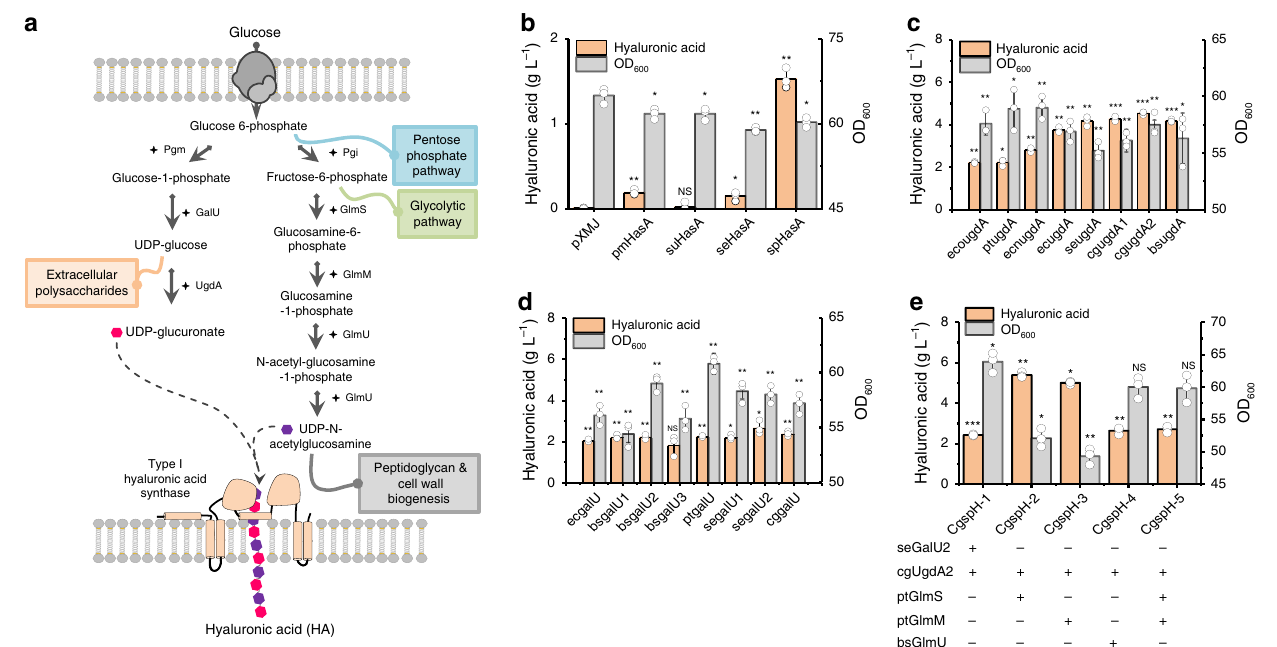
Fig. 1 Engineering C. glutamicum for HA biosynthesis from glucose. a HA chains are elongated by HA synthase (HasA) from two building blocks: UDP- GlcA (uridine diphosphate glucuronate) and UDP-GlcNAc (uridine diphosphate N-acetylglucosamine). Pgm, phosphoglucomutase; GalU, glucose-1- phosphate uridylyltransferase; UgdA, UDP ‐ glucose 6 ‐ dehydrogenase; Pgi, glucose-6-phosphate isomerase; GlmS, L -glutamine- D -fructose-6-phosphate aminotransferase; GlmM, phosphoglucosamine mutase; GlmU, UDP-N-acetylglucosamine pyrophosphorylase/Glucosamine-1-phosphate N- acetyltransferase. b HA synthesis by P. multocida (pmHasA), S. pyogenes (spHasA), S. uberis (suHasA), and S. equi subsp. zooepidemicus HasA (seHasA), respectively in C. glutamicum . c , d Comparison of the activities of UgdA and GalU from different species on enhancing HA production. e Co-overexpression of C. glutamicum cgUgdA2 with S. equi subsp. zooepidemicus seGalU2, P. putida ptGlmS, P. putida ptGlmM or B. subtilis bsGlmU to enhance HA production. All the data are expressed as the mean ± S.D. from three ( n = 3) biologically independent replicates. Statistical evaluation ( p -value) compared to strain pXMJ ( a ), spHasA ( b , c ), or cgugdA2 ( e ) was performed by two-sided t -test. * p < 0.05, ** p < 0.01, *** p < 0.001; NS not signi fi cant ( p ≥ 0.05). Source data underlying Fig. 1b – e are provided as a Source data fi